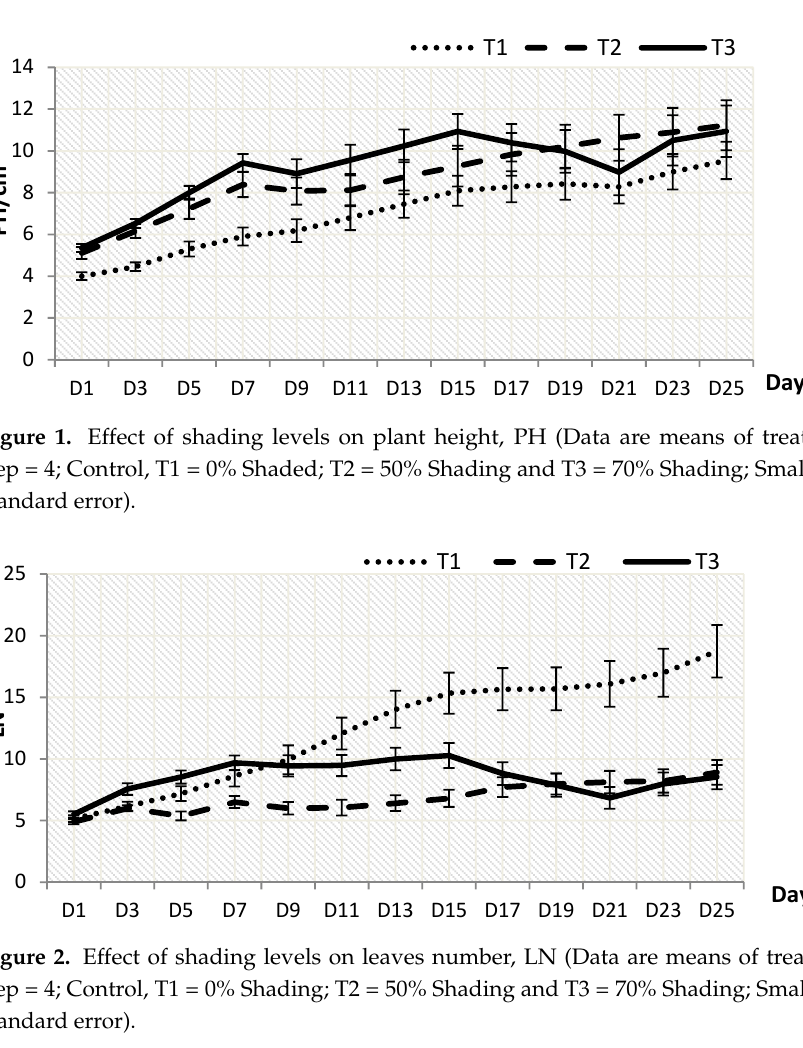
Figure 2. Effect of shading levels on leaves number, LN (Data are means of treatments, N = 96; Rep = 4; Control, T1 = 0% Shading; T2 = 50% Shading and T3 = 70% Shading; Small bars represent standard error).